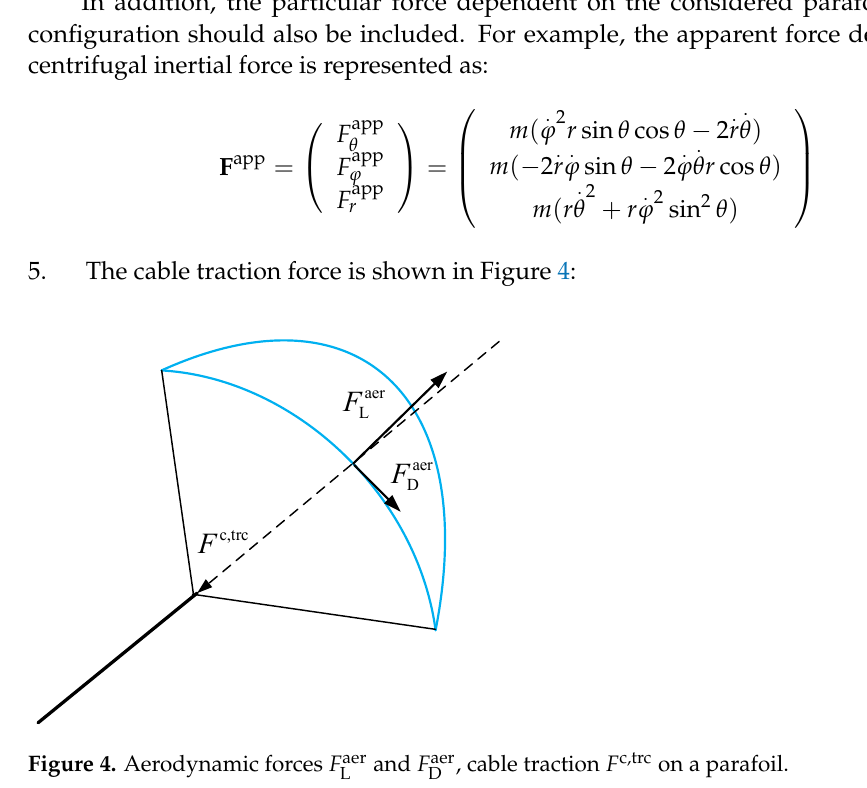
Figure 4. Aerodynamic forces aer